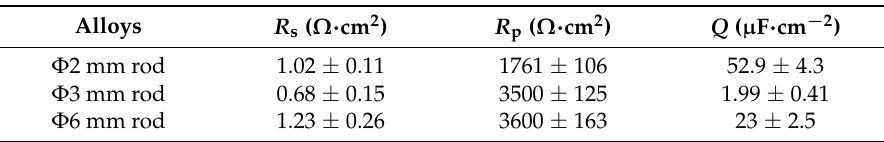
Table 2. Equivalent circuit parameters of electrochemical impedance spectroscopy (EIS) results including the root-mean-square deviation of the values.